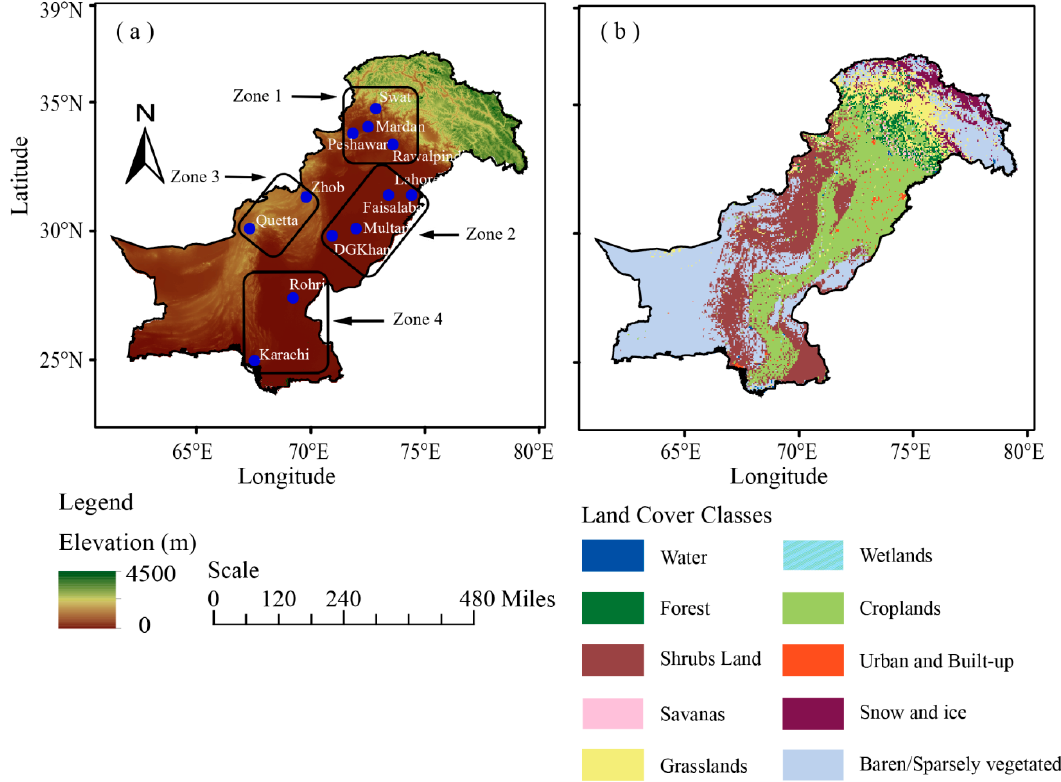
Figure 1. Map of the study domain showing ( a ) Elevation and locations of the selected regions and ( b ) land cover. The elevation map is based on Shuttle Radar Topography Mission (STRM) data [44]; whereas, the land cover map is based on the Terra and Aqua combined MODIS Land Cover Type (MCD12Q1) Version 6 data product available on [45]. The four zones in Figure 1(a) correspond to the selected regions with similar topography and climatology. Table 1. Information of selected regions, multiyear mean AOD (2003–2017); annual, summer (JJAS) and winter (DJF) along with standard deviations (SD) from the mean, acquired from MODIS-Terra DB product. The Population record (in millions) is based on 2017 census [46]; the numbers in brackets show the urban percentage for each region.